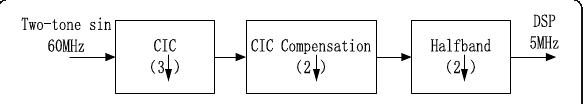
Fig. 7 Down-conversion design block diagram